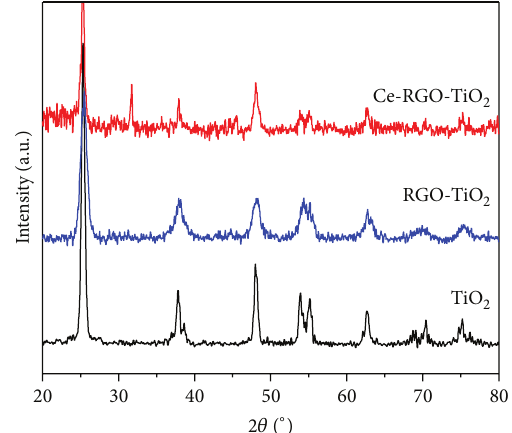
Figure 3: XRD pattern of pure TiO 2 , RGO-TiO 2 , and Ce-RGO- TiO 2